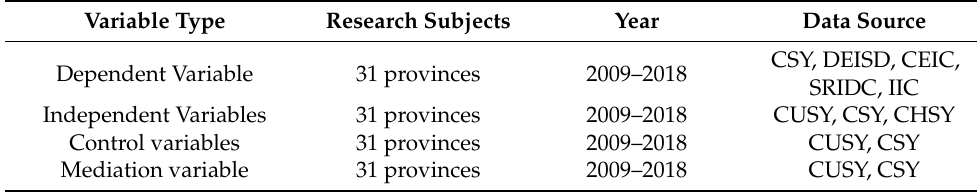
Table 3. Variables and Data